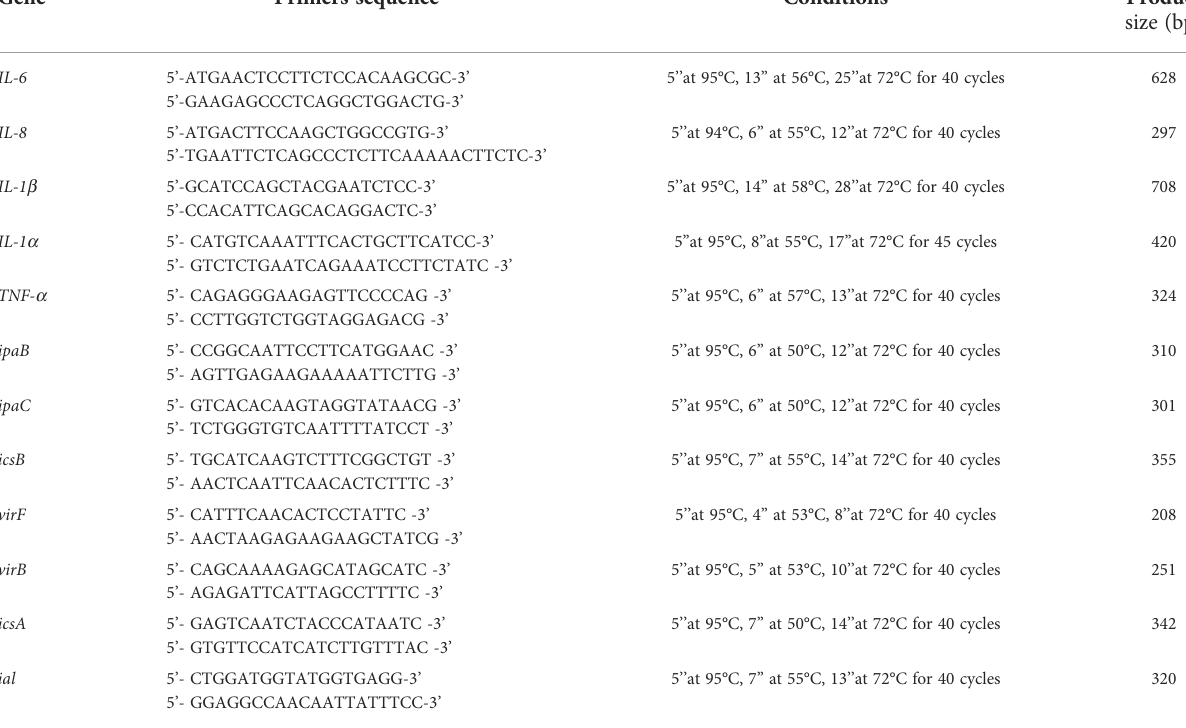
TABLE 1 Primers sequences and ampli fi cation